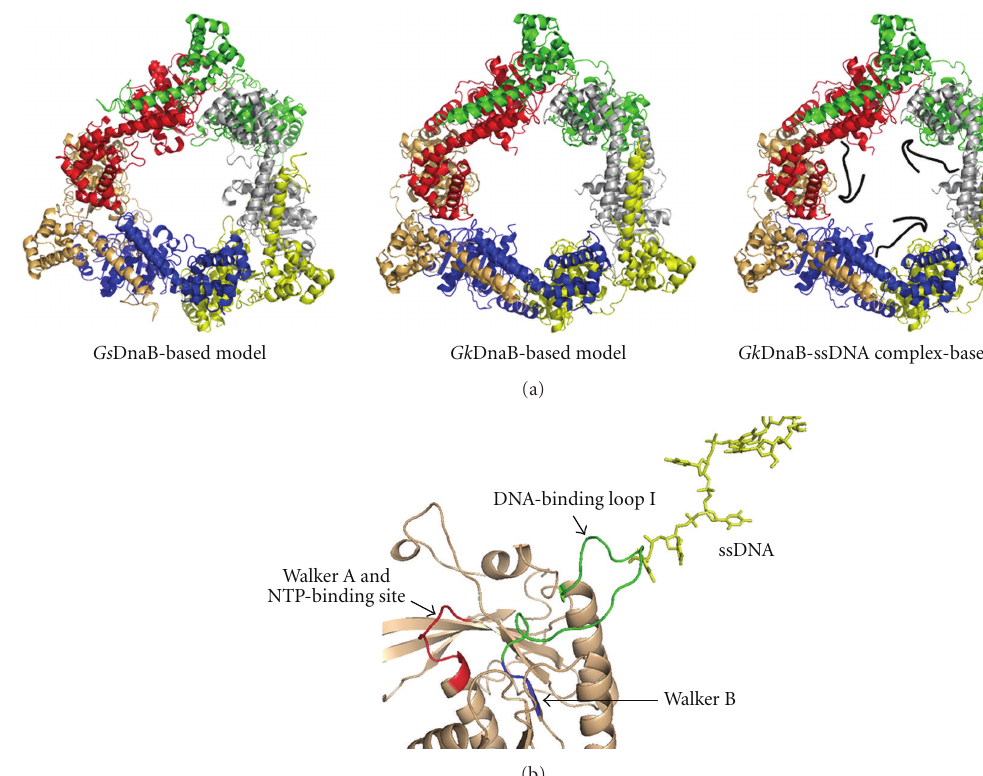
Figure 7: Homology modeling. (a) The three-dimensional models of the hexameric Kp DnaB form a ring structure. The monomers are colored di ff erently. ssDNA is colored in black. (b) The structural model of the Kp DnaB-ssDNA complex. The NTP-binding site, Walker A and B motifs, is adjacent to the DNA interaction site loop I (green). There are synergistic e ff ects between the nucleotide and ssDNA binding [7]. The Walker A and B motifs are colored in red and blue, respectively. ssDNA is colored in